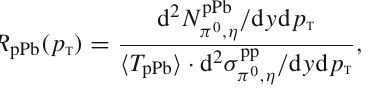
Fig. 8 π 0 (left) and η (right) nuclear modification factors R pPb mea- sured in NSD p–Pb collisions at − 1 . 365 < y cms < 0 . 435 at √ s NN = 5.02 TeV compared to the nuclear modification factors of charged pions and charged kaons, respectively. The statistical uncer-